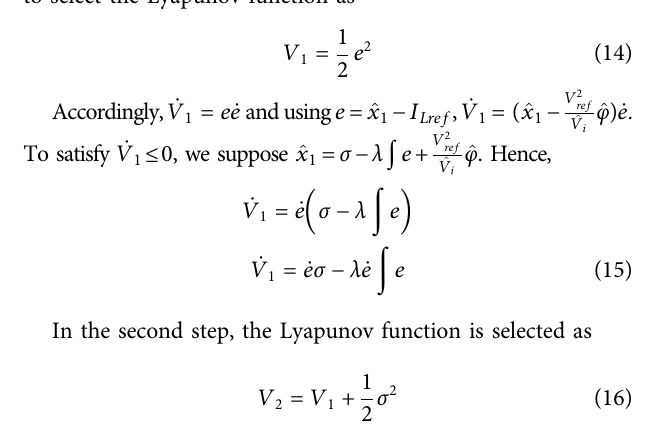
Frontiers in Energy Research |